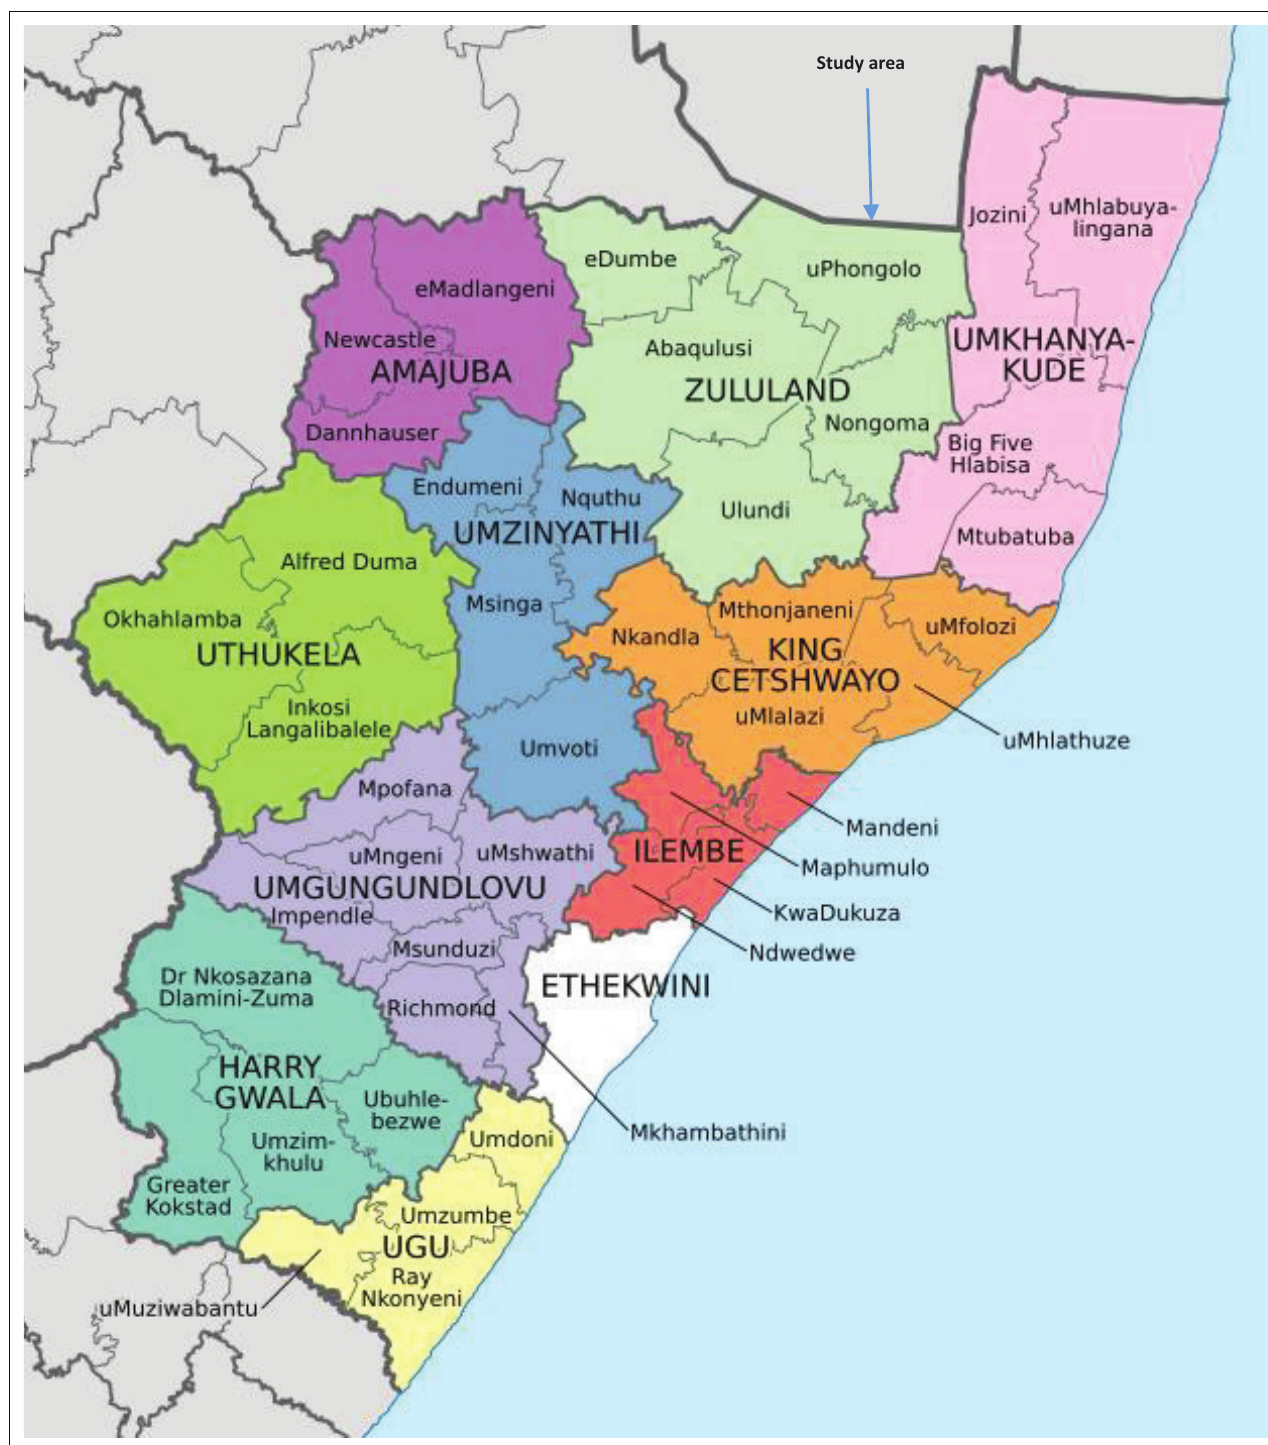
FIGURE 1: Map of the study area: uPhongolo local municipality (one of the five local municipalities with the Zululand District